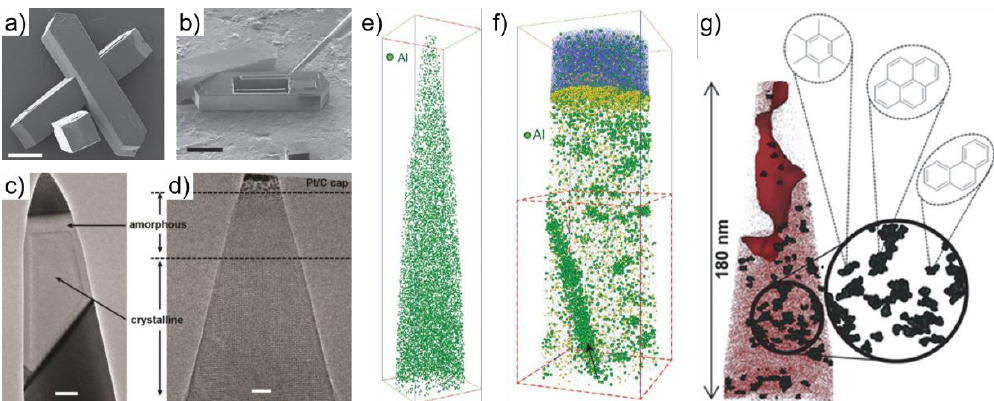
Figure 15. Towards the analysis of zeolites by APT. ( a ) Helium Ion Microscope image of a ZSM-5 sample (scale bar: 20 µm); ( b ) sample preparation by FIB lift-out (scale bar: 25 µm); ( c ) and ( d ) TEM of the APT specimen highlighting the damage suffered during sample preparation: the crystalline structure is embedded in an amorphous shell due to Ga implantation (scale bars: ( c ) 100 nm and ( e ) 20 nm); 3D atom map of the Al distribution within a ZSM-5 specimen ( e ) before any treatment, representing a homogeneous distribution and ( f ) after steam treatment, where the formation of Al clusters is apparent, as well as segregation to a grain boundary; ( g ) coke formation on a ZSM-5 zeolite after methanol-to-hydrocarbon reaction using 13 C label. The red dots correspond to 13 C atoms, and the black regions correspond to 13 C-clusters, with possible coke species produced (consistent with the cluster size, even though APT do not provide such detailed molecular fingerprints).